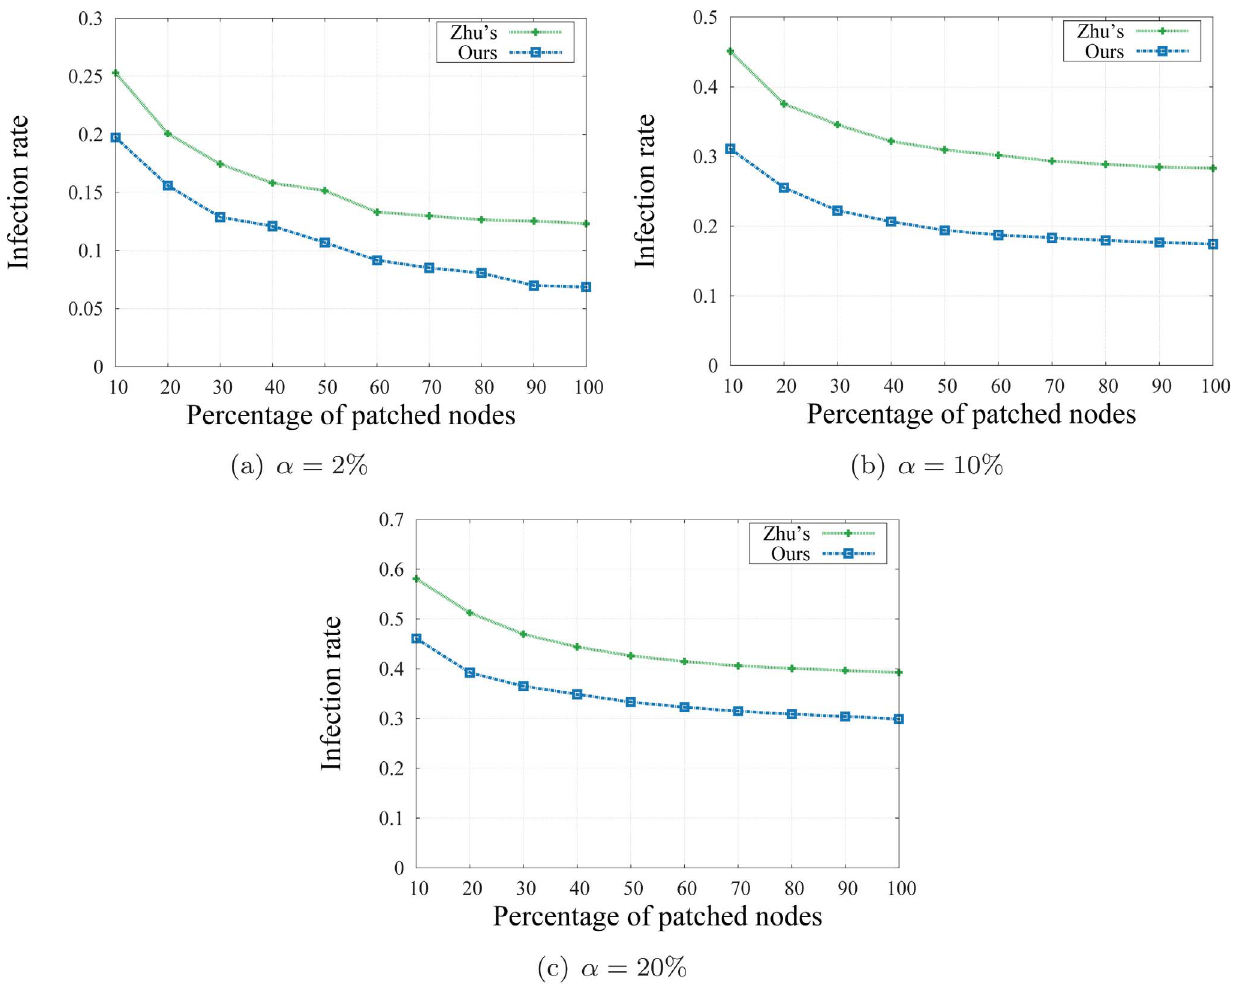
Figure 9. Infection rates on static network with k =150 clusters.